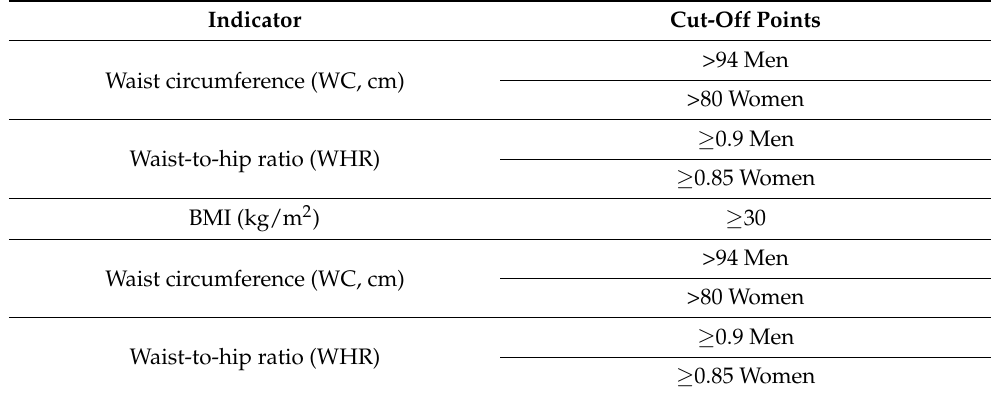
Table 1. World health organization cut-off points and increased risk of metabolic complications.